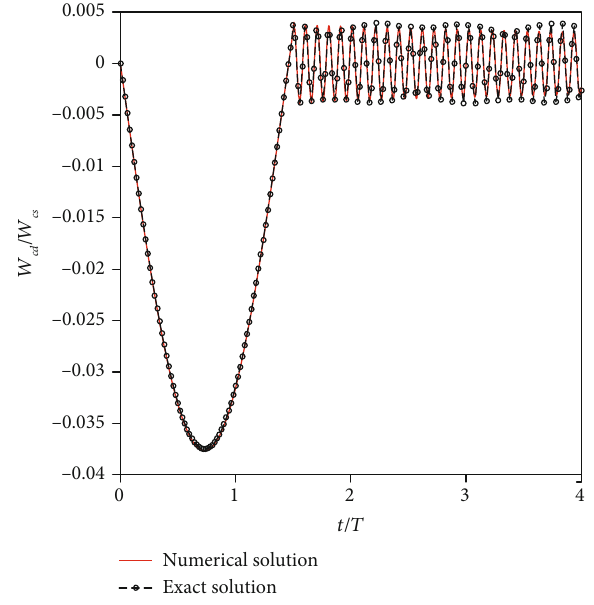
Figure 14: Central displacement of a simply supported beam subjected to a sinusoidal piezoelectric impulse for t d = 1 : 5 T , Ω = / L = ð 0 : 6,0 : 9 Þ . π , x a